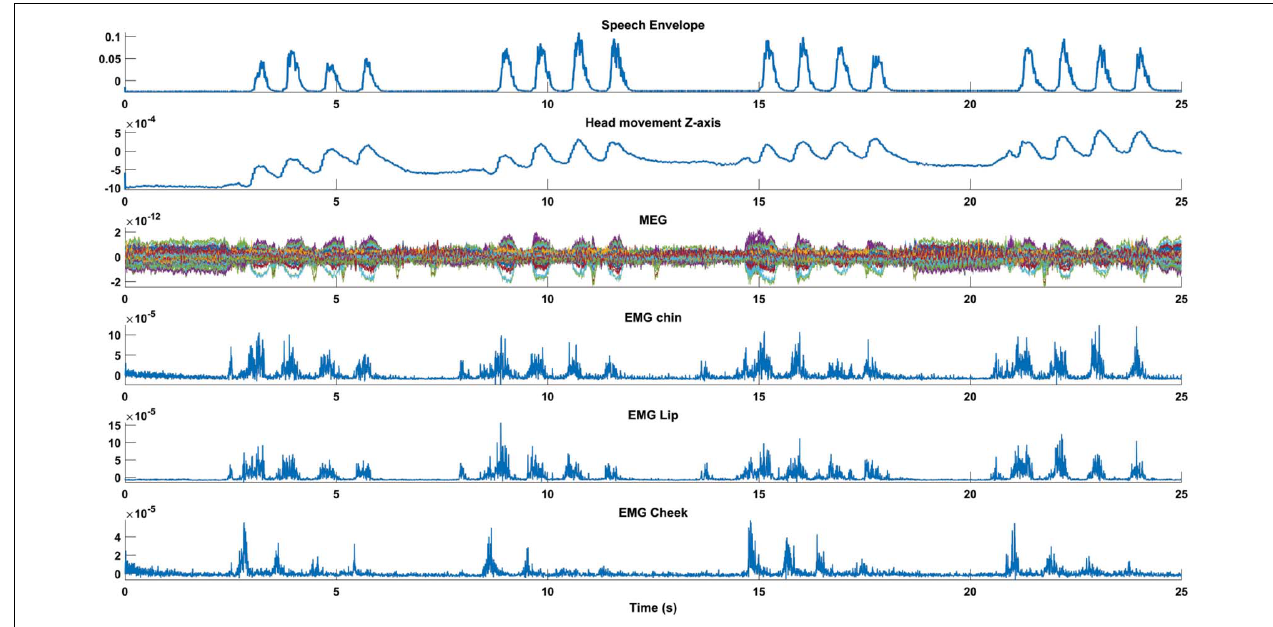
FIGURE 4 | Temporal alignments between speech envelope and MEG. The first 25 s of an individual time-series from MEG, EMG, speech envelope, and head movements are illustrated for condition Pa/loud. The strong temporal alignment between these signals shows that syllable pronunciation causes head movements and results in MEG